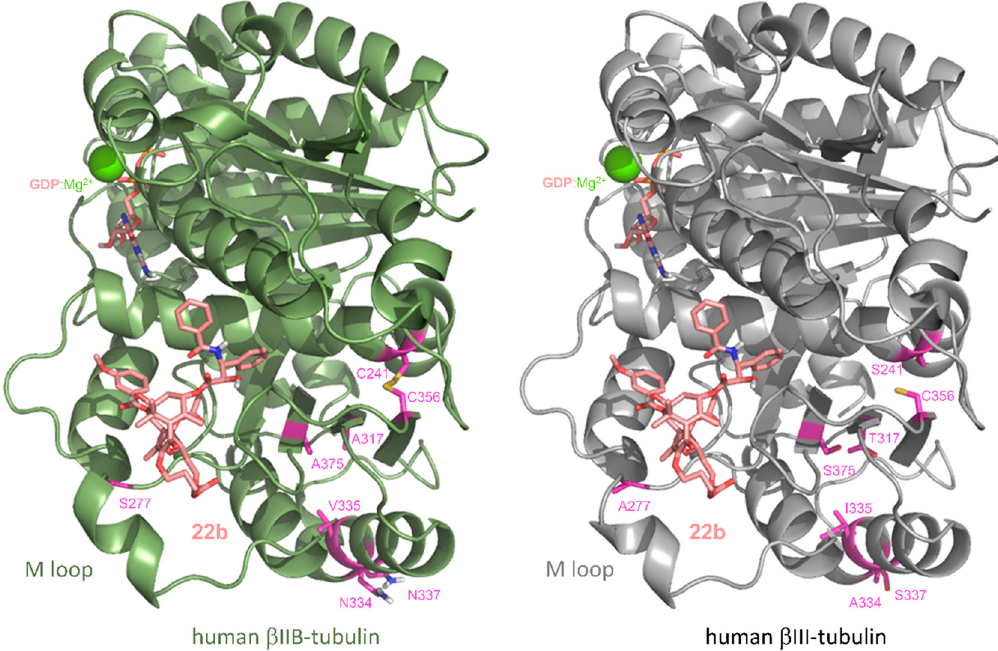
Figure 4. 22b docked into homology models of human tubulins IIb and III bound to guanosine diphosphate (GDP)-Mg 2+ . Colored in magenta and labeled are those residues close to the taxane-binding site that differ between these two isotypes.